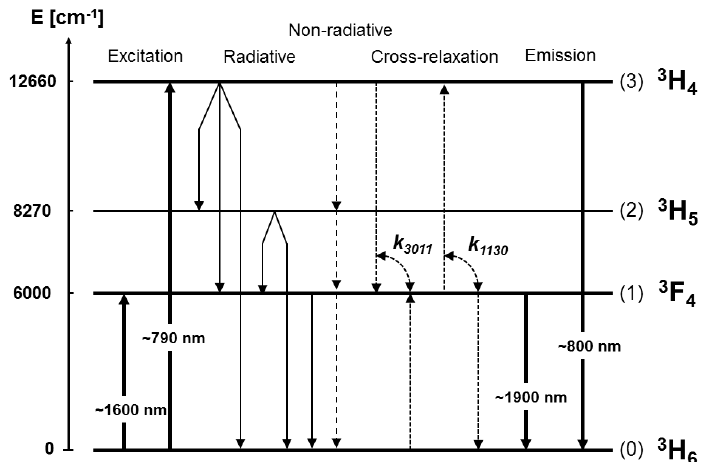
Figure 3. Energy levels of Tm 3+ ion including possible energy transitions between energy levels with the indication of cross-relaxation energy-transfer coefficients. The numbers in the arrows in the diagram are the wavelengths (in nanometers) of the corresponding transitions [23].